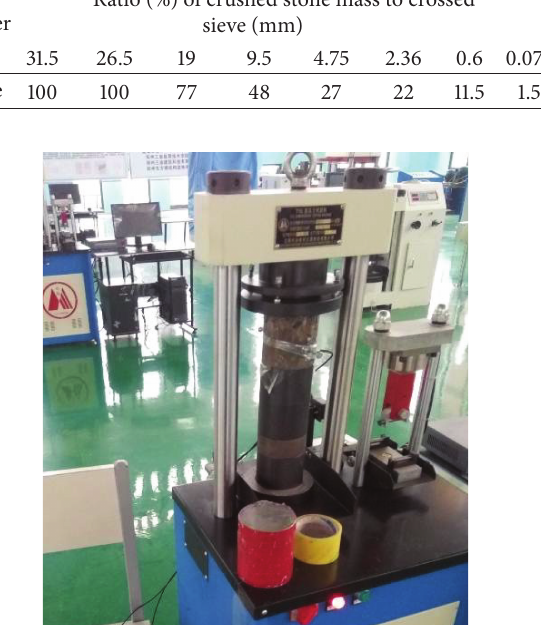
Figure 2: Mechanical testing machine.